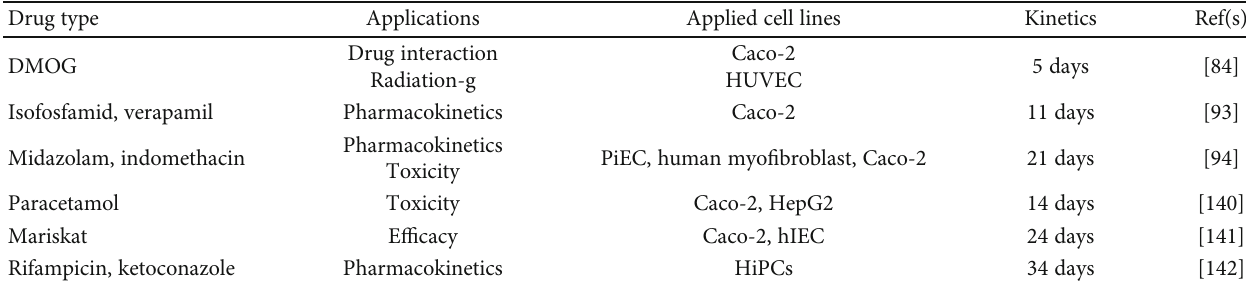
Table 4: Summary of recent advancements in gut-on-chip platforms including the type of drug, the applications, the applied cell lines, and the